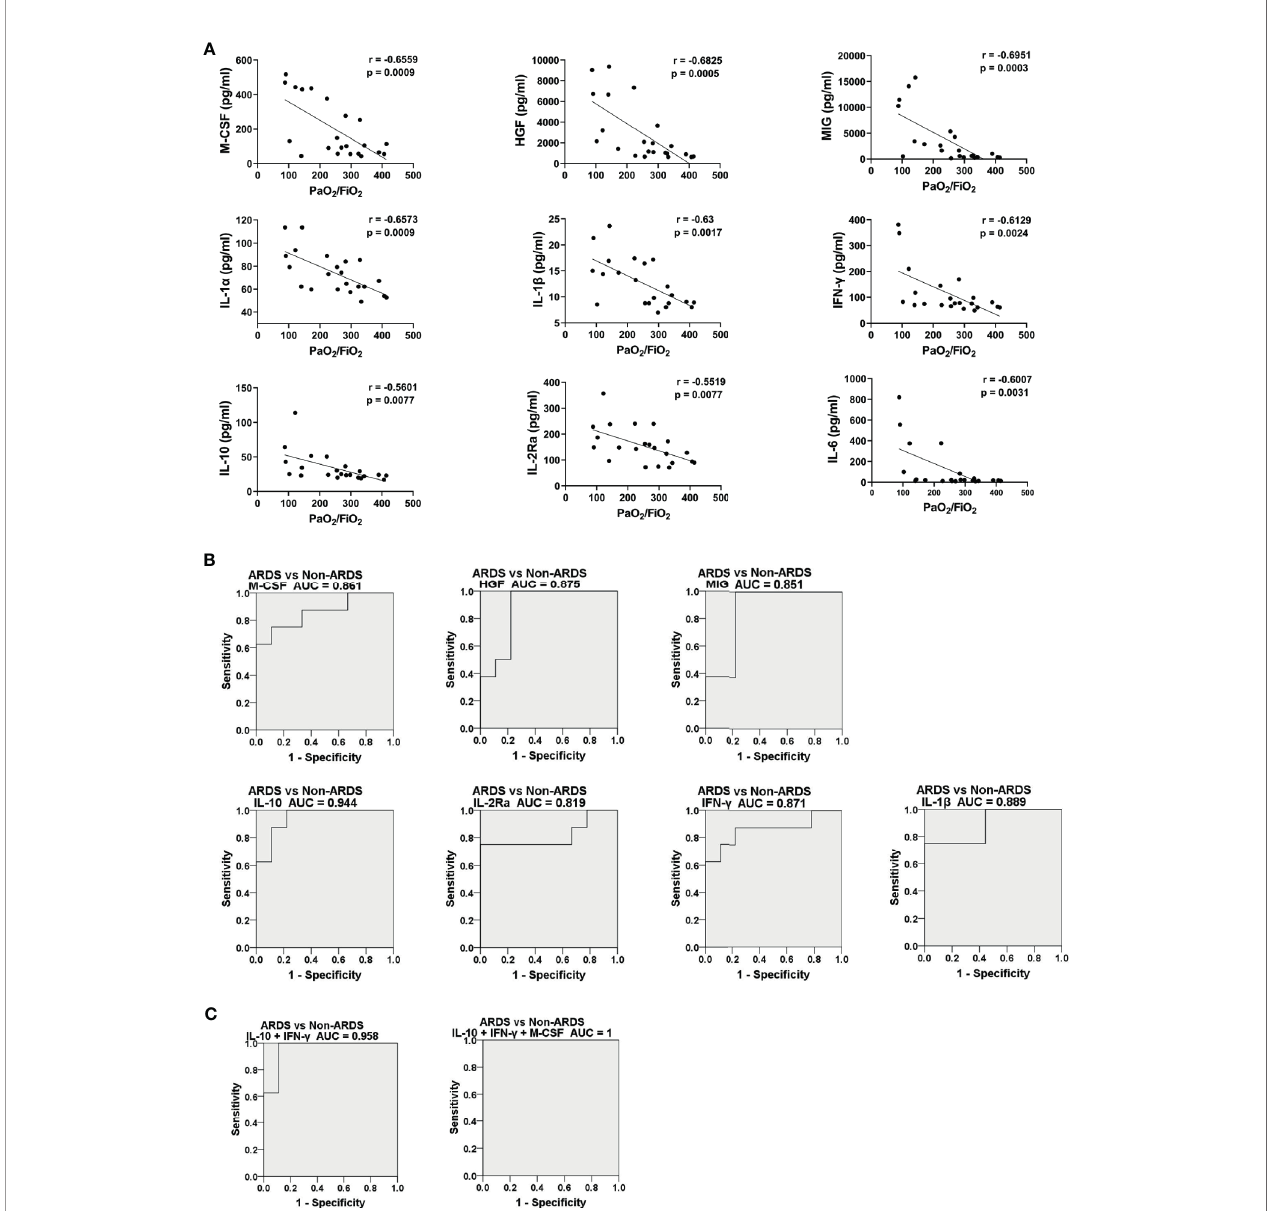
FIGURE 3 | Expression of IL-10, M-CSF, MIG, HGF, IL-1 b , IFN- g and IL-2Ra was closely associated with disease severity and could predict disease progression. (A) Spearman rank correlation analysis between expression of HGF, MIG, IFN- g , IL-1 b , IL-6, M-CSF, IL-10, IL-1 a and IL-2Ra measured from plasma samples and the corresponding PaO 2 /FiO 2 ratio on the same day. (B) ROC curves of expression levels of HGF, MIG, IFN- g , IL-1 b , M-CSF, IL-10, and IL-2Ra upon hospital admission for HAdV-infected patients with and without ARDS during hospitalization. (C) ROC curves of different combination of IL-10, IFN- g , and M-CSF expression levels upon hospital admission for HAdV-infected patients with and without ARDS during hospitalization. All P-values for the ROC curves were